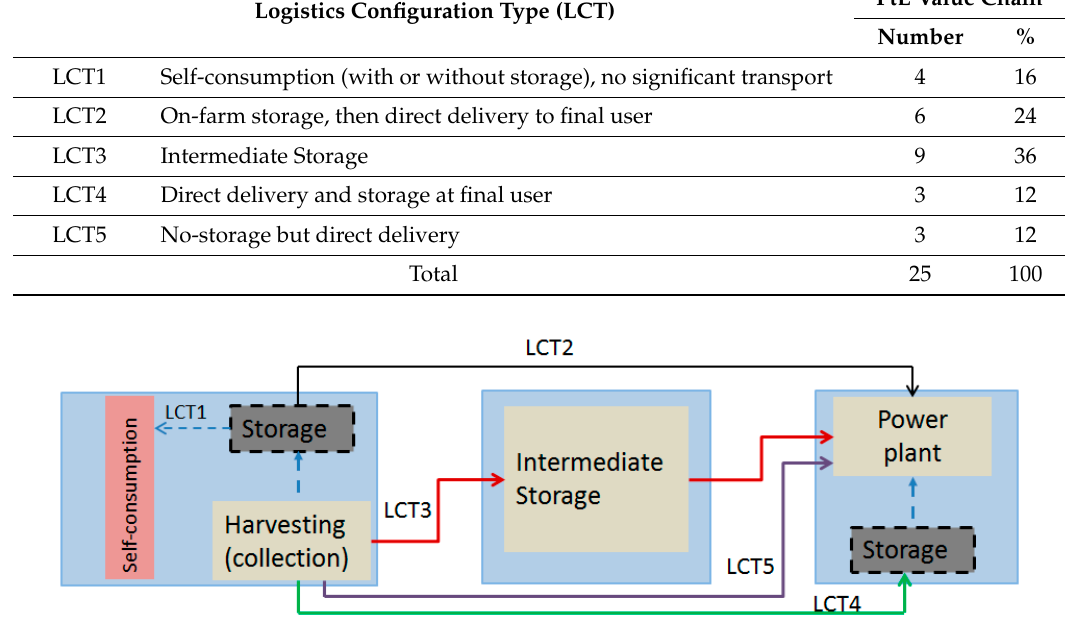
Table 2. Major logistics configuration types. PtE—pruning-to-energy.